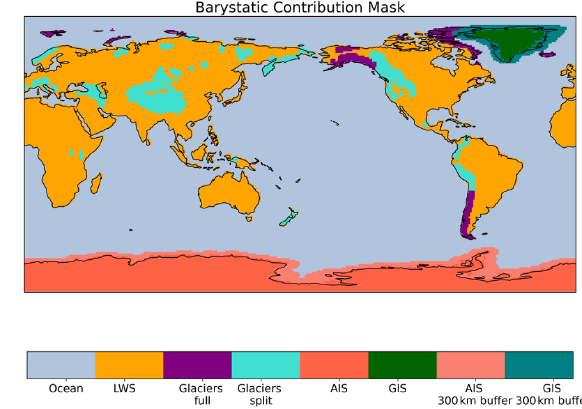
Figure B1. Mask of the different contributions to barystatic sea- level change.